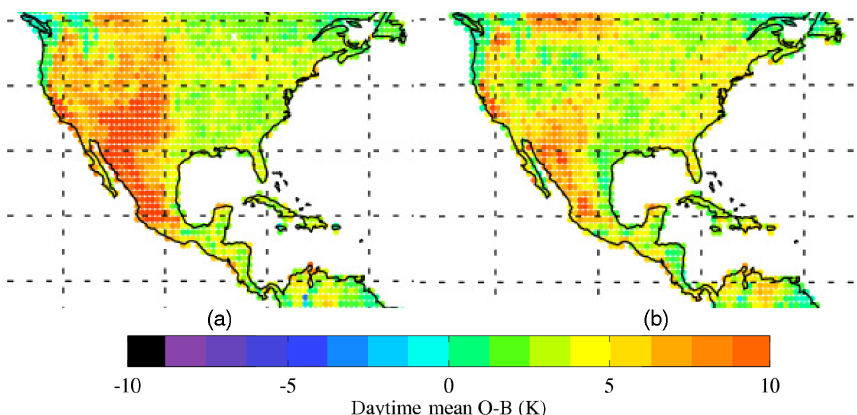
Figure 1. UM surface temperature biases (O-B) compared to IASI 1D-VAR retrievals for the North American continent during (a) GA/L3.1, May 2013, and (b) GA/L6.1_17km_static, May